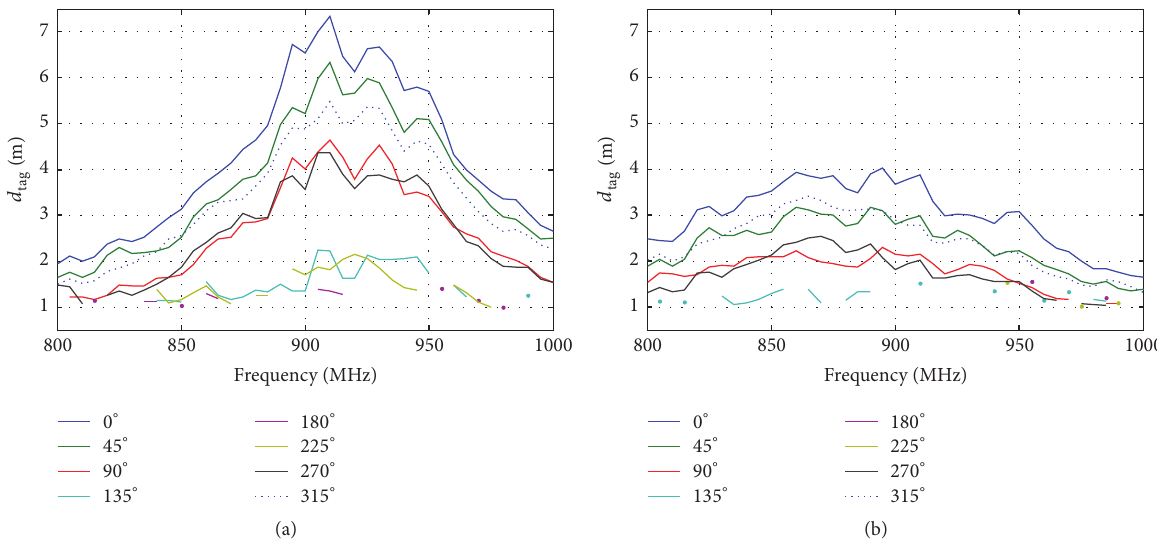
Figure 7: Measured attainable read range of the copper tape (a) and e-textile (b) tags attached to upper back.